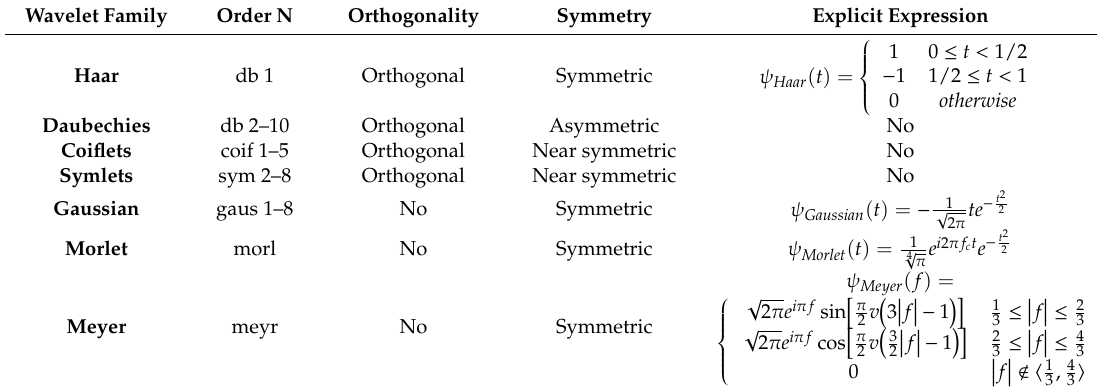
Table 3. Brief summary of the definitions and main properties of the studied wavelet families. Wavelet